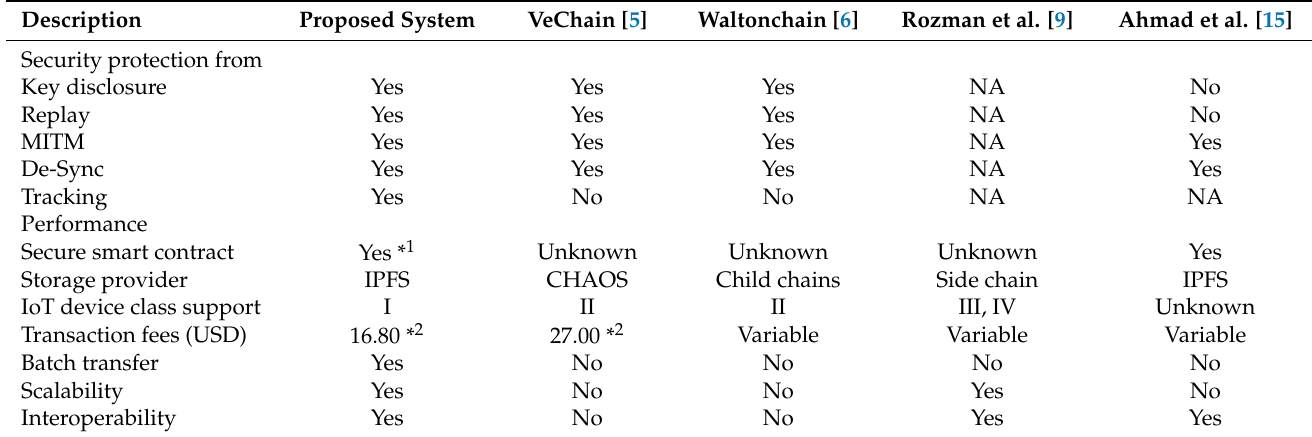
Table 5. State-of-the-art and proposed protocol